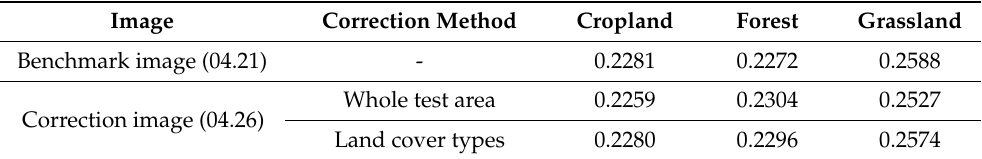
methods and the benchmark